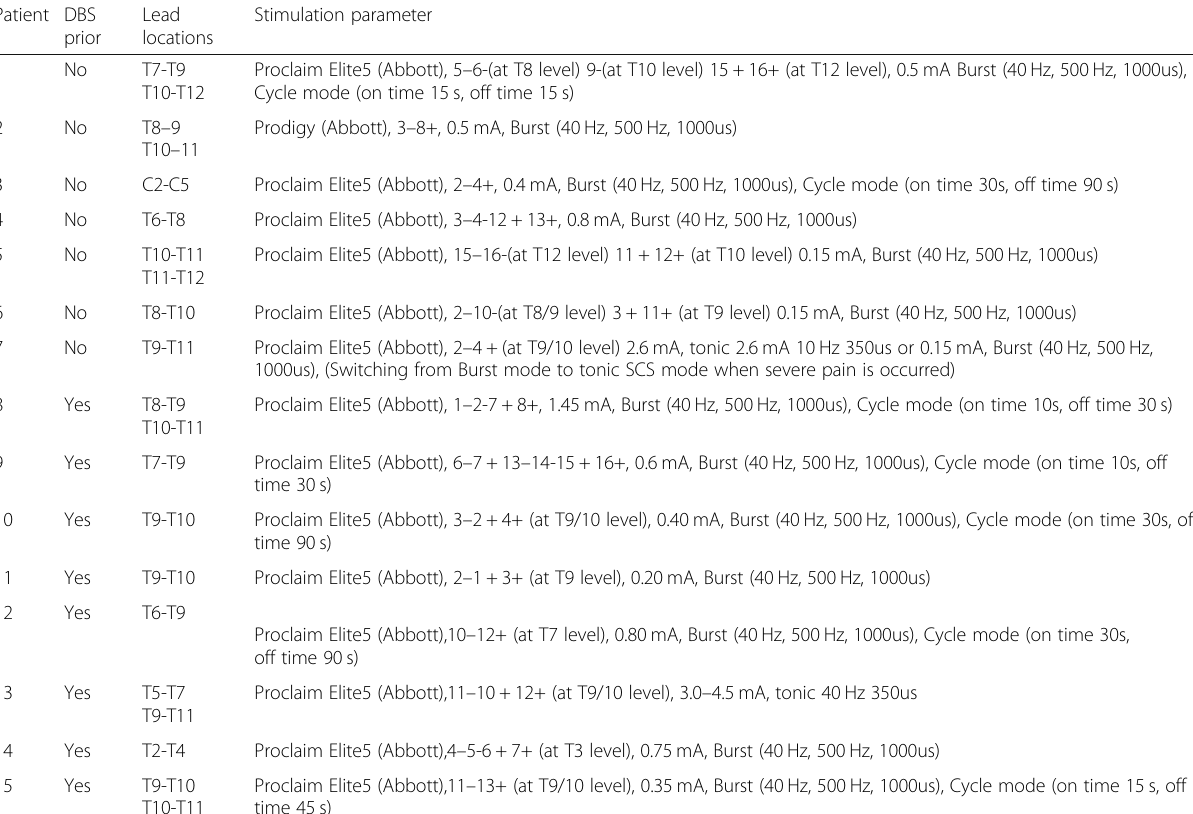
Table 2 Lead locations and stimulation parameters Patient DBS prior